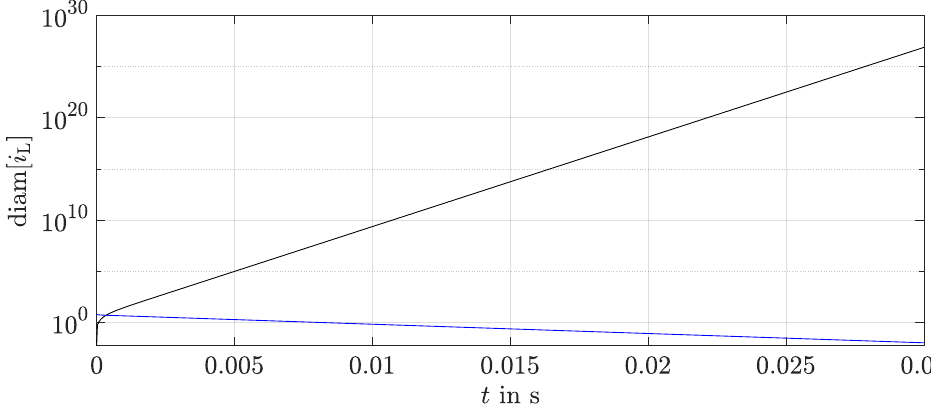
Figure 6. Interval width resulting from the cooperative approach in blue and from the state-of-the-art Taylor series prediction in black for the state variable i L